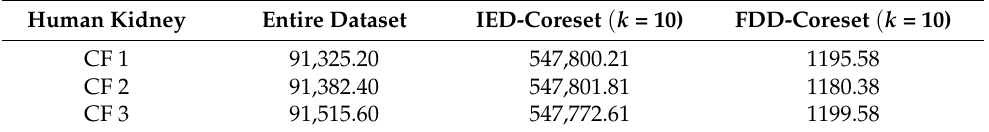
Table 4. Computation time comparison of BlobGAN trained on entire dataset (1000 random samples), IED-Coreset ( k = 10) and proposed FDD-Coreset ( k = 10) on 3D human kidney images (unit: seconds). Human Kidney Entire